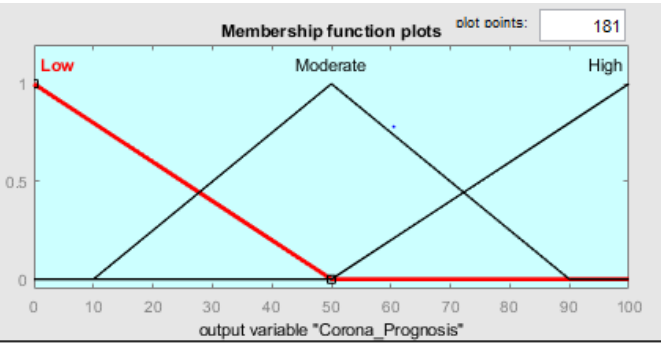
Fig. 5. MF for output variable corona prognosis.